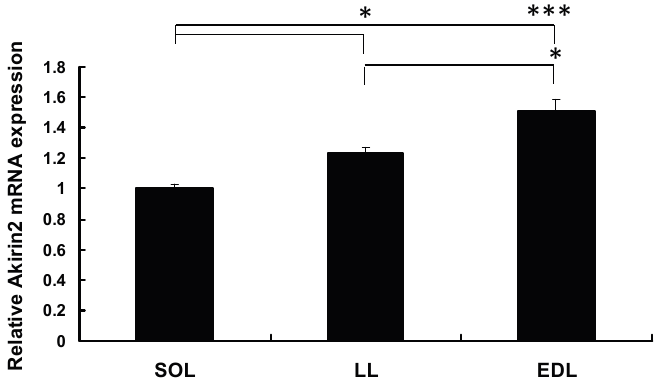
Figure 1. Relative Akirin2 mRNA expression in different types of muscle tissues of pigs. Total RNA from slow soleus (SOL), longissimus lumborum (LL) and extensor digitorum longus (EDL) muscles of three healthy Duroc × Landrace × Yorkshire (DLY) pigs was used to perform the real-time quantitative PCR. Samples were performed in duplicate. The amount of Akirin2 mRNA was normalized to the amount of p β -actin mRNA. Data were presented as means ± SE ( n = 3), in arbitrary units. * p < 0.05, *** p < 0.001.